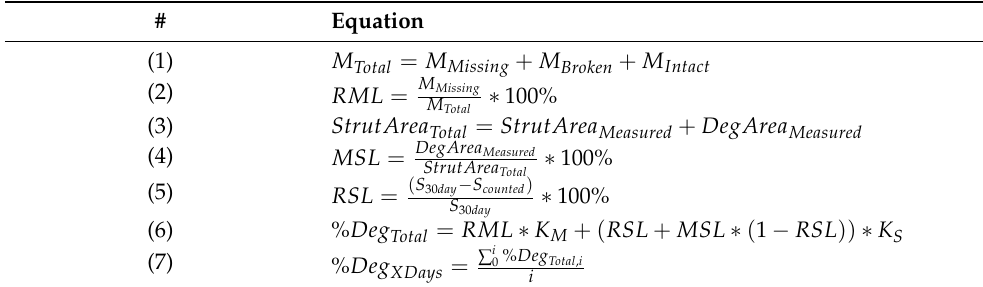
Table 4. The equations listed below represent the degradation quantification method, inclusive of large mass-loss